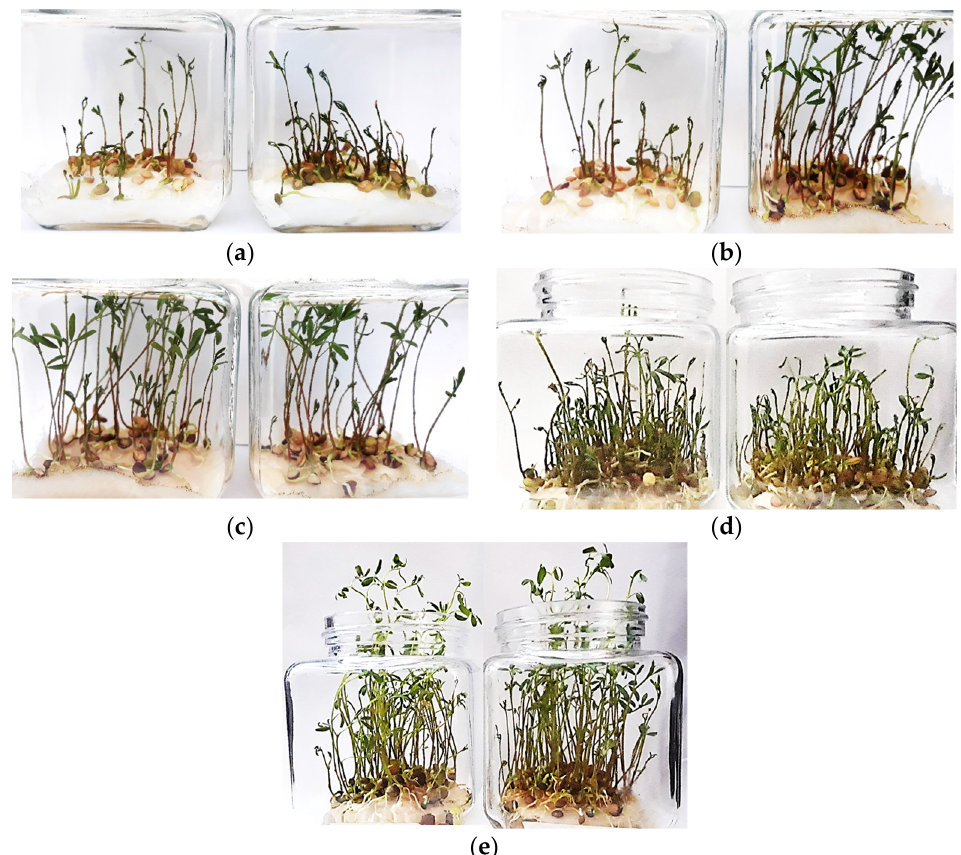
Figure 4. Comparative images of experimental tests after the fourth time of irrigation: ( a ) PW ( left ) vs. ANTP ‐ PW ( right ), ( b ) PW ( left ) vs. FW ( right ), both without treatment, ( c ) ANTP ‐ FW ( left ) vs. DNTP ‐ FW ( right ), ( d ) RW ( left ) vs. ANTP ‐ RW ( right ); in fifth time of irrigation; ( e ) FW ( left ) vs. ANTP ‐ FW ( right ).